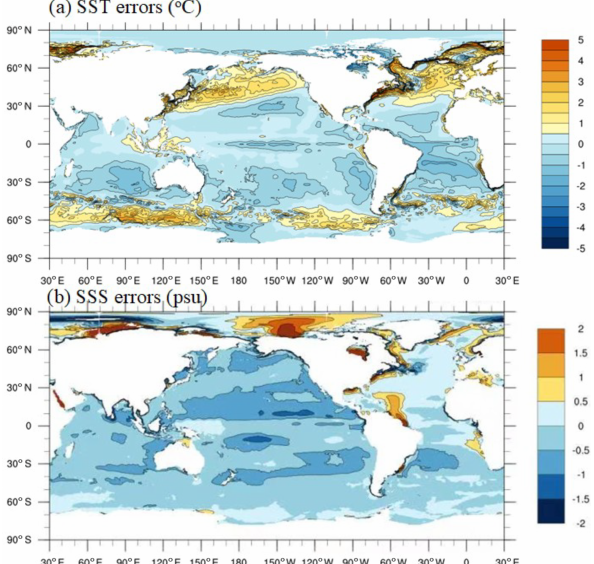
Figure 13. The spatial distribution of time mean errors of (a) sea surface temperature (SST) and (b) sea surface salinity (SSS) simu- lated by the CPE-parallelized CESM-HR on the Sunway machine.